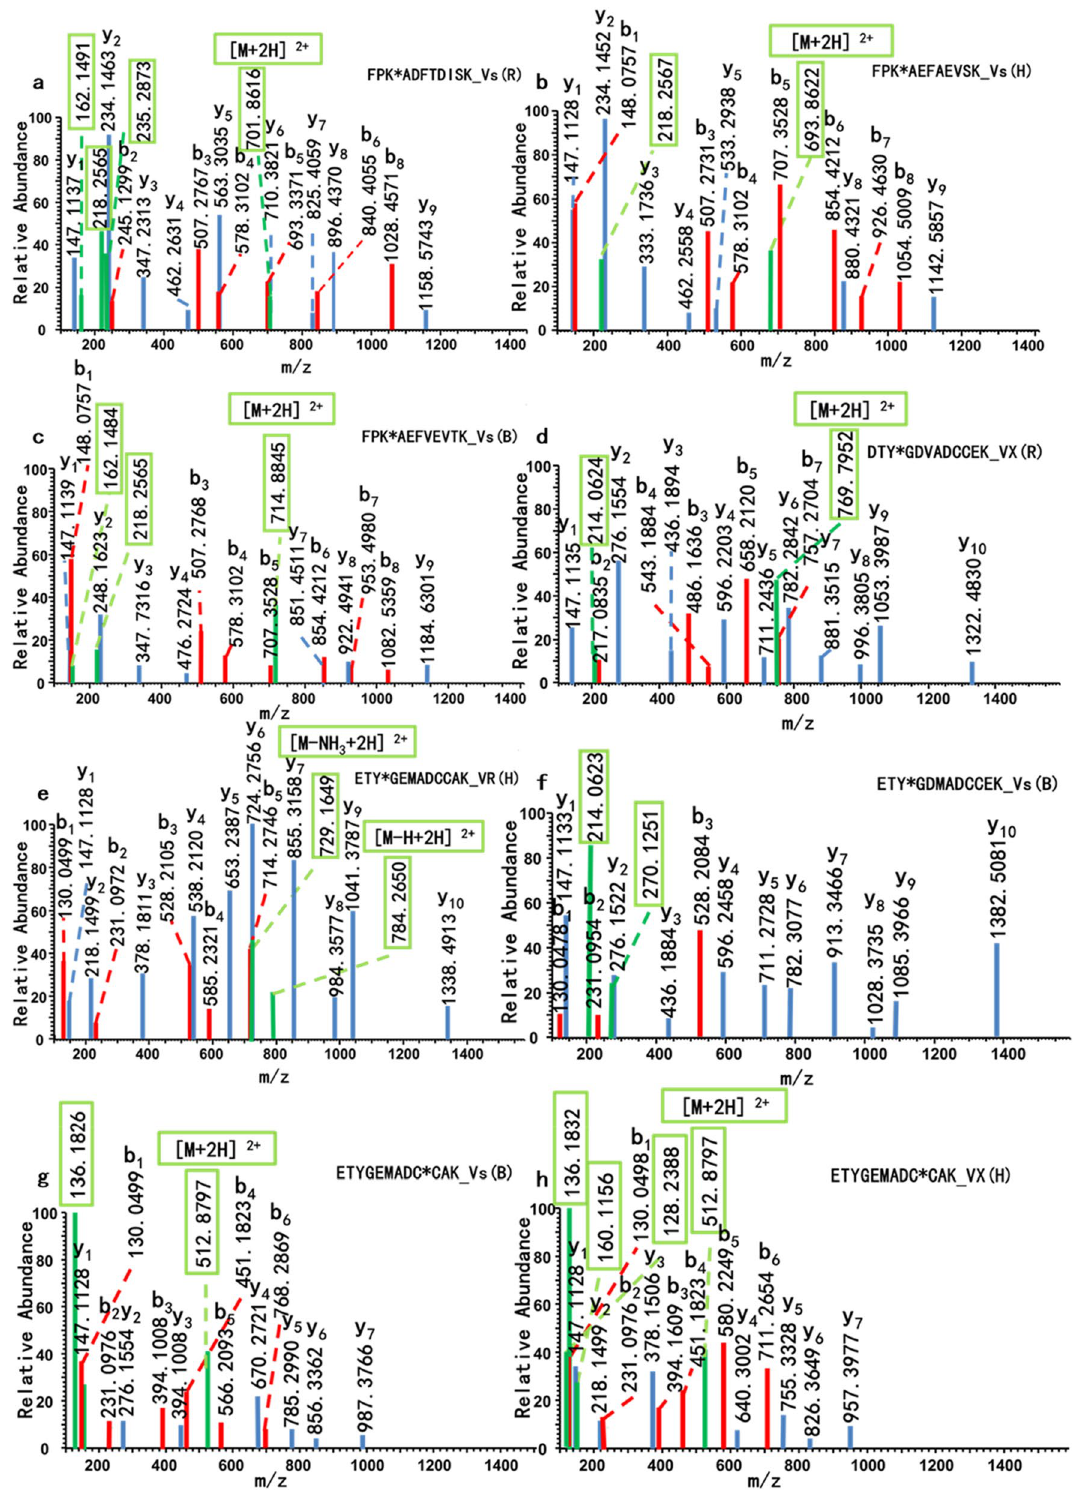
Figure 2. MS/MS spectra of labeled peptides in albumins after V-type OPNAs exposure. ( a – c ) showed K249 on FPK*ADFTDISK in RSA, FPK*AEFAEVSK in HSA and FPK*AEFVEVTK in BSA all phosphonylated by Vs. ( d – f ) showed Y108 on ETY*GDVADCCEK in RSA, ETY*GEMADCCAK in HSA and ETY*GDMADCCEK in BSA phosphonylated by VX, VR, Vs, respectively. ( g – h ) showed C114 on ETYGDMADC*CEK in BSA and ETY*GEMADCCAK in HSA were binding to Vs and VX, respectively. Key peaks marked in blue lines for y-ion series, red lines for b-ion series and green lines for characteristic precursor